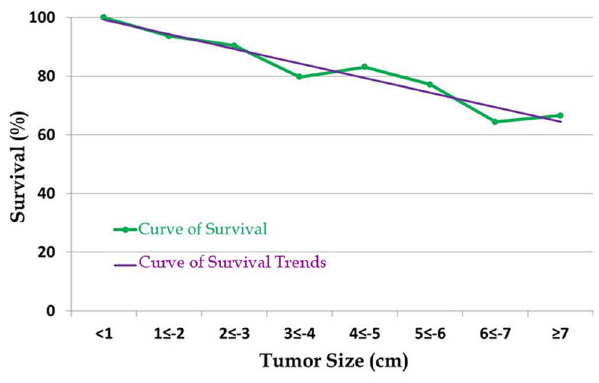
Figure 4. Distribution of survival by 1 cm tumor size intervals.